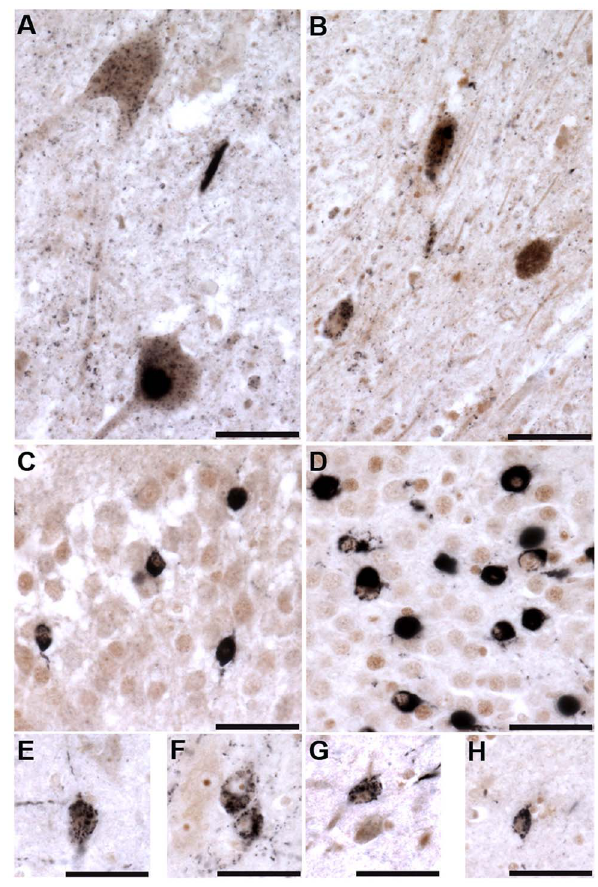
Figure 5. Tau tubulin kinases are co-expressed with phospho- TDP-43 pathology in ALS cases. TTBK1 (brown; A, C, E, F) and TTBK2 (brown; B, D, G, H) co-localize with phospho-TDP-43 (black) in spinal cord motor neurons (A, B), hippocampal dentate granule cells (C, D), cortical neurons (E, G), hippocampal CA3 pyramidal neurons (F) and subiculum (H). Scale bars=50 m